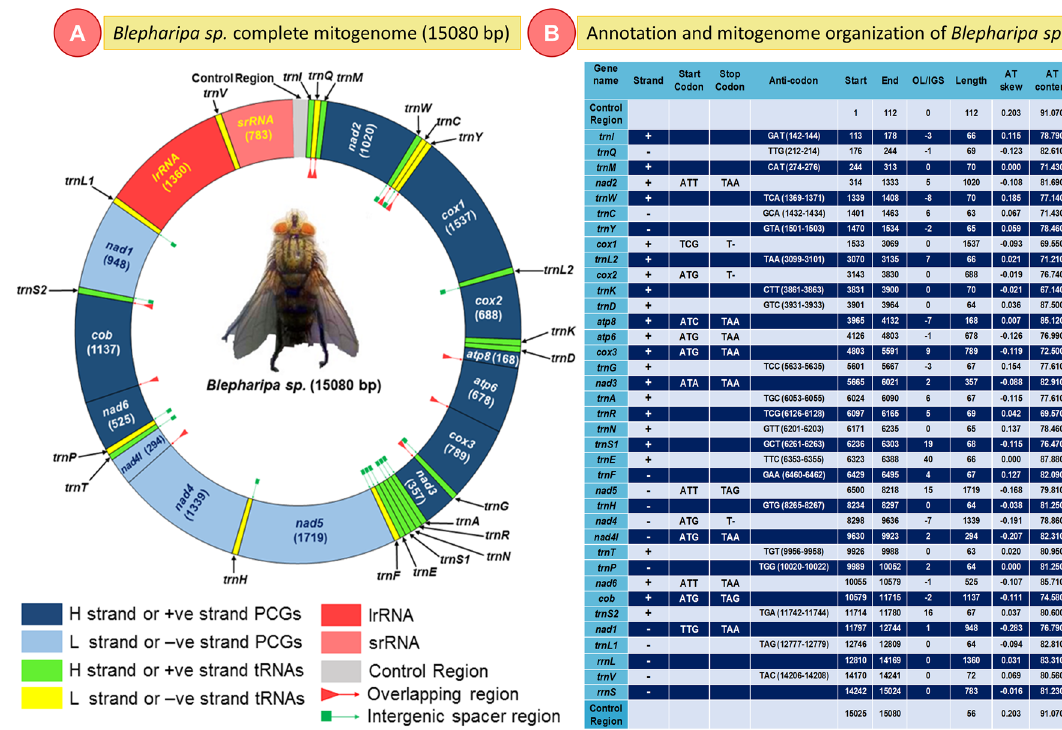
Figure 2. Complete mitochondrial genome structure of Blepharipa sp.; ( A ) Circular Map ( B ) Annotation and genome organization of mitogenome. tRNAs are represented as trn followed by the IUPAC-IUB single letter amino acid codes e.g., trnI denote tRNA-Ile